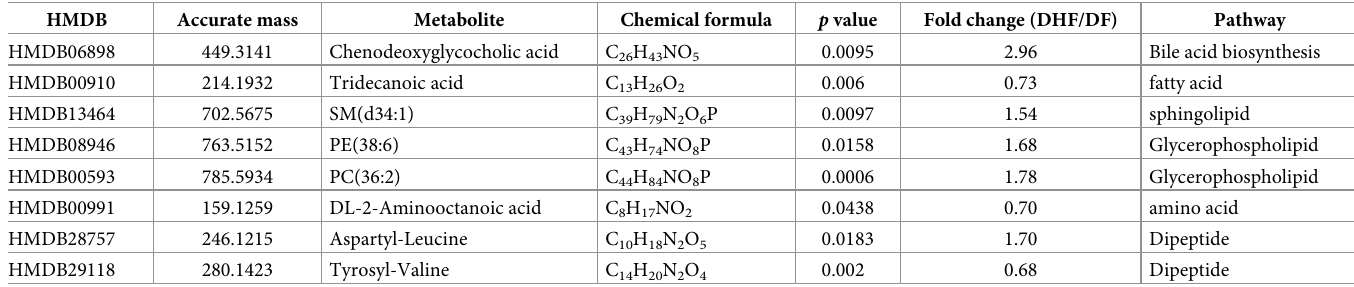
Table 2. Identified differentially expressed metabolites between DF and DHF patients in the recovery phase of dengue infection. HMDB Accurate mass Metabolite Fold change (DHF/DF)